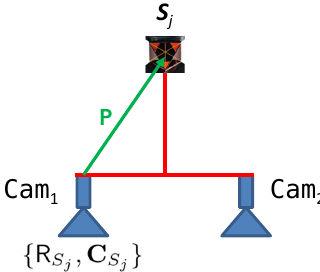
Figure 5: The geometry concerning the relationship of the pri- mary camera and the 360 ◦ prism for the case of bundle adjust- ment with incorporated tachymeter measurements. The vector P represents the position of the 360 ◦ prism w.r.t. the primary cam- era Cam 1